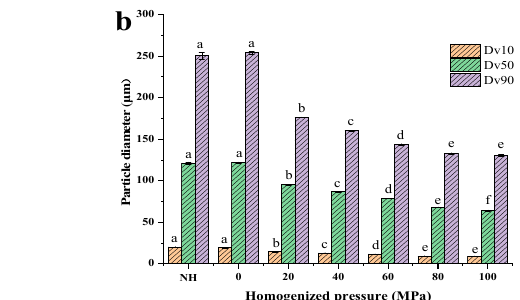
Figure 1. Effect of high-pressure homogenization (NH = non-homogenized; 0–100 MPa) on particle size distribution (PSD) ( a ) and cumulative diameter percentiles (Dv10, Dv50, and Dv90) ( b ) of lily pulp. Dv10, Dv50, and Dv90 indicated that 10%, 50% or 90% of the particles fell below the specified diameter. Different letters in the column indicated that the samples were significantly different ( p < 0.05).